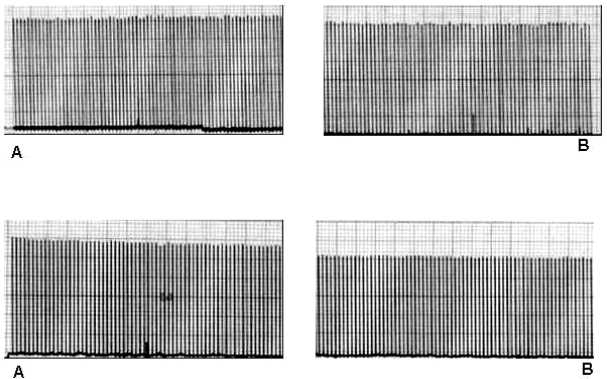
FIGURE 1 - Muscular responses to indirect stimulation of in vitro (n=5) phrenic nerve-diaphragm preparation (upper tracing) and of in vivo (n=5) sciatic nerve-tibialis anterior muscle preparation (lower trac- ing) of rats previously exposed to phenobarbital (20mg/kg). A = stimu-